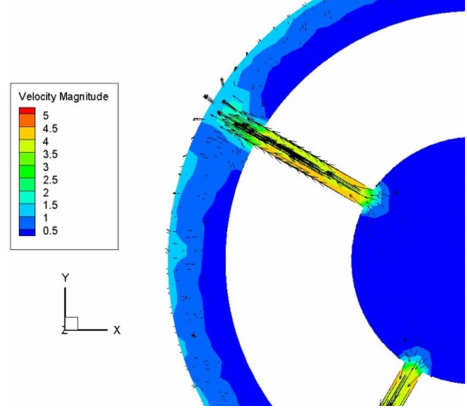
Fig. 8. Fluid flow vector outside spiral groove.